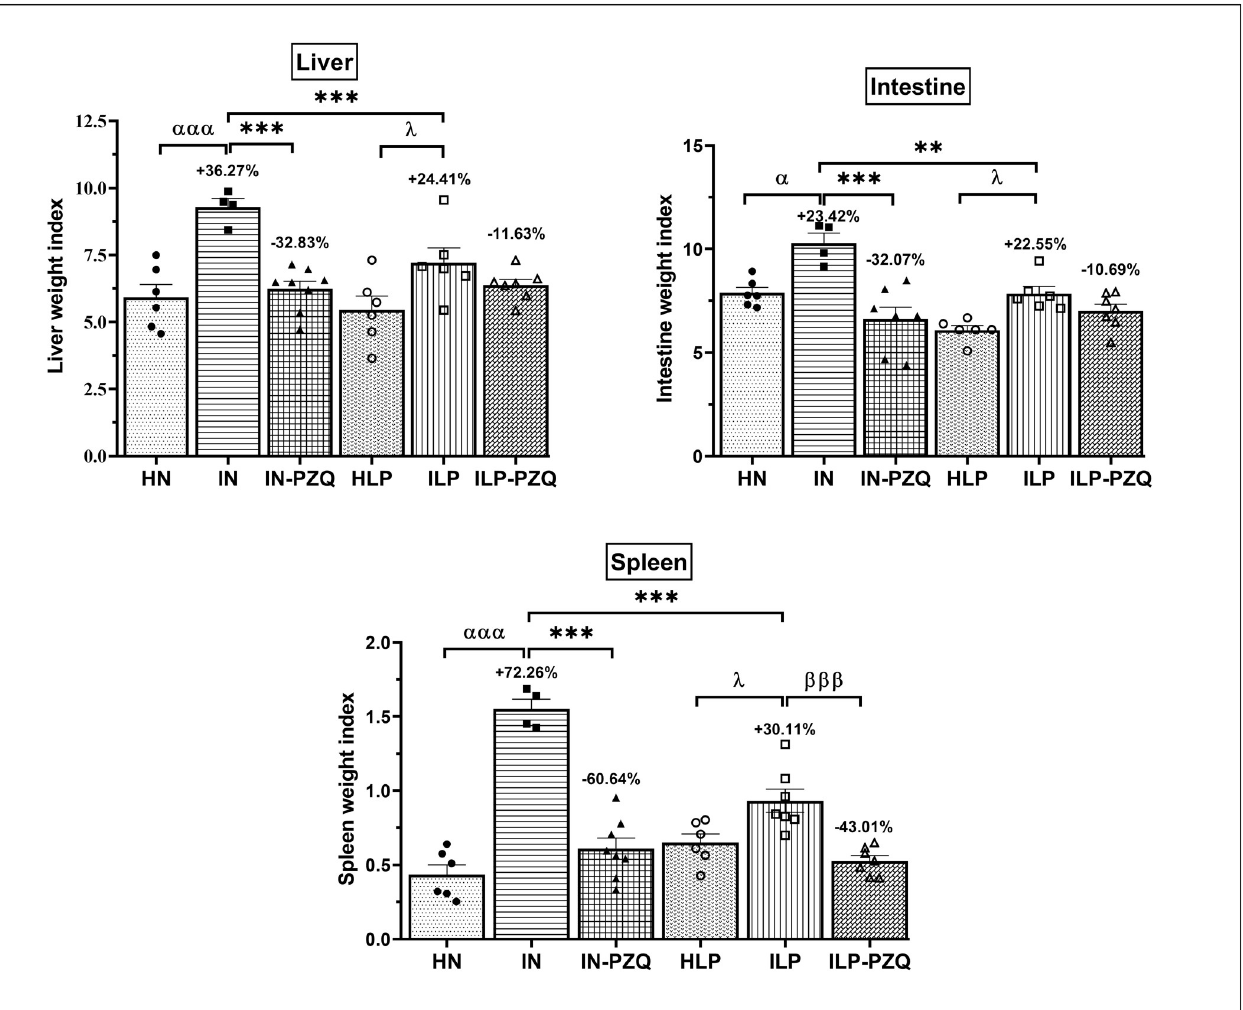
Fig 2. Effects of praziquantel treatment on the organs weight indexes of Schistosoma mansoni -infected mice receiving a low-protein diet. Data are expressed as mean ± SEM (n = 4–8). Group HN: healthy mice receiving a standard diet; group IN: infected-untreated mice receiving a standard diet; group IN-PZQ: infected mice receiving a standard diet and treated with praziquantel; group HLP: healthy mice receiving a low-protein diet; group ILP: infected- untreated mice receiving a low-protein diet; group ILP-PZQ: infected mice receiving a low-protein diet and treated with praziquantel. ANOVA followed by Turkey’s multiple comparison test. α P < 0.05; ααα P < 0.001: values are significantly different from the healthy normal nourished animals (group HN). �� P < 0.01 ��� P < 0.001: values are significantly different from the infected-untreated mice receiving a standard diet (group IN). λ P < 0.05; values are significantly different from healthy mice receiving a low-protein diet (group HLP). βββ P < 0.001: values are significantly different from infected-untreated mice receiving a low-protein diet (group ILP). The number on top of each bar graph represents the percentage of variation.